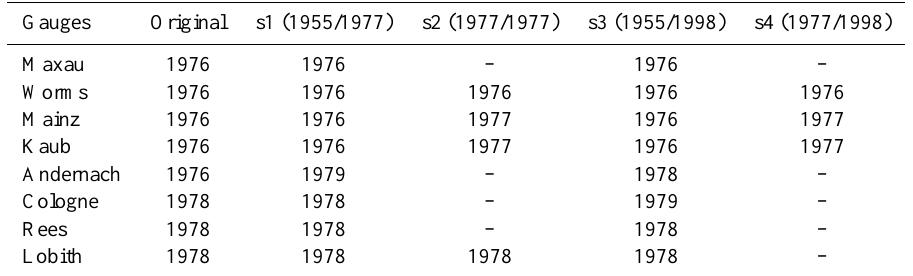
Table 2. Year of the most significant change point at 5% significance level in original and homogenised time series. A dash indicates no significant change